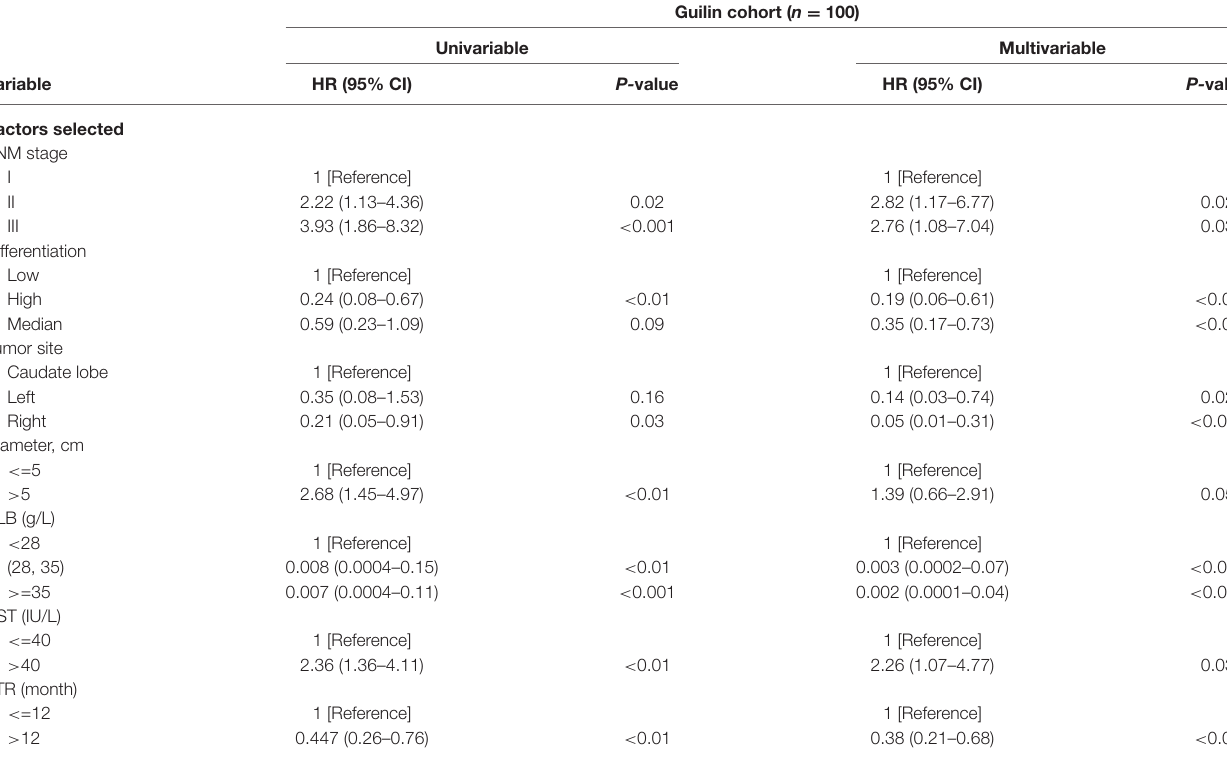
TABLE 1 | Cox proportional hazards regression model showing the association of variables with post-recurrence